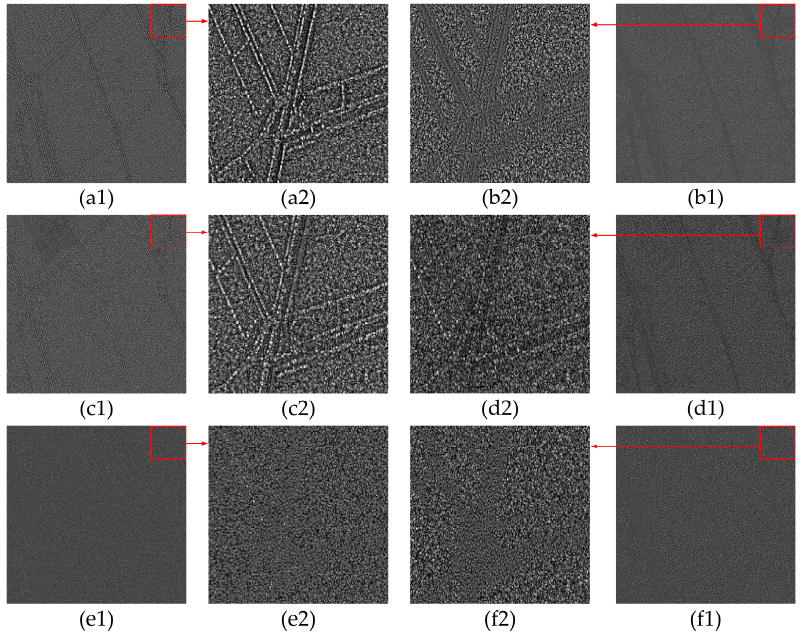
Figure 5. Ratio images by noisy GF-3 SAR image and the ( a1 ) SRAD, ( b1 ) DPAD, ( c1 ) EnLee, ( d1 ) PPB, ( e1 ) SAR-BM3-D, and ( f1 ) FANS filtered images. ( a2 – f2 ) are the enlarged images of the red rectangle from ( a1 – f1 ). Table 3. Index evaluation of the GF-3 SAR image.